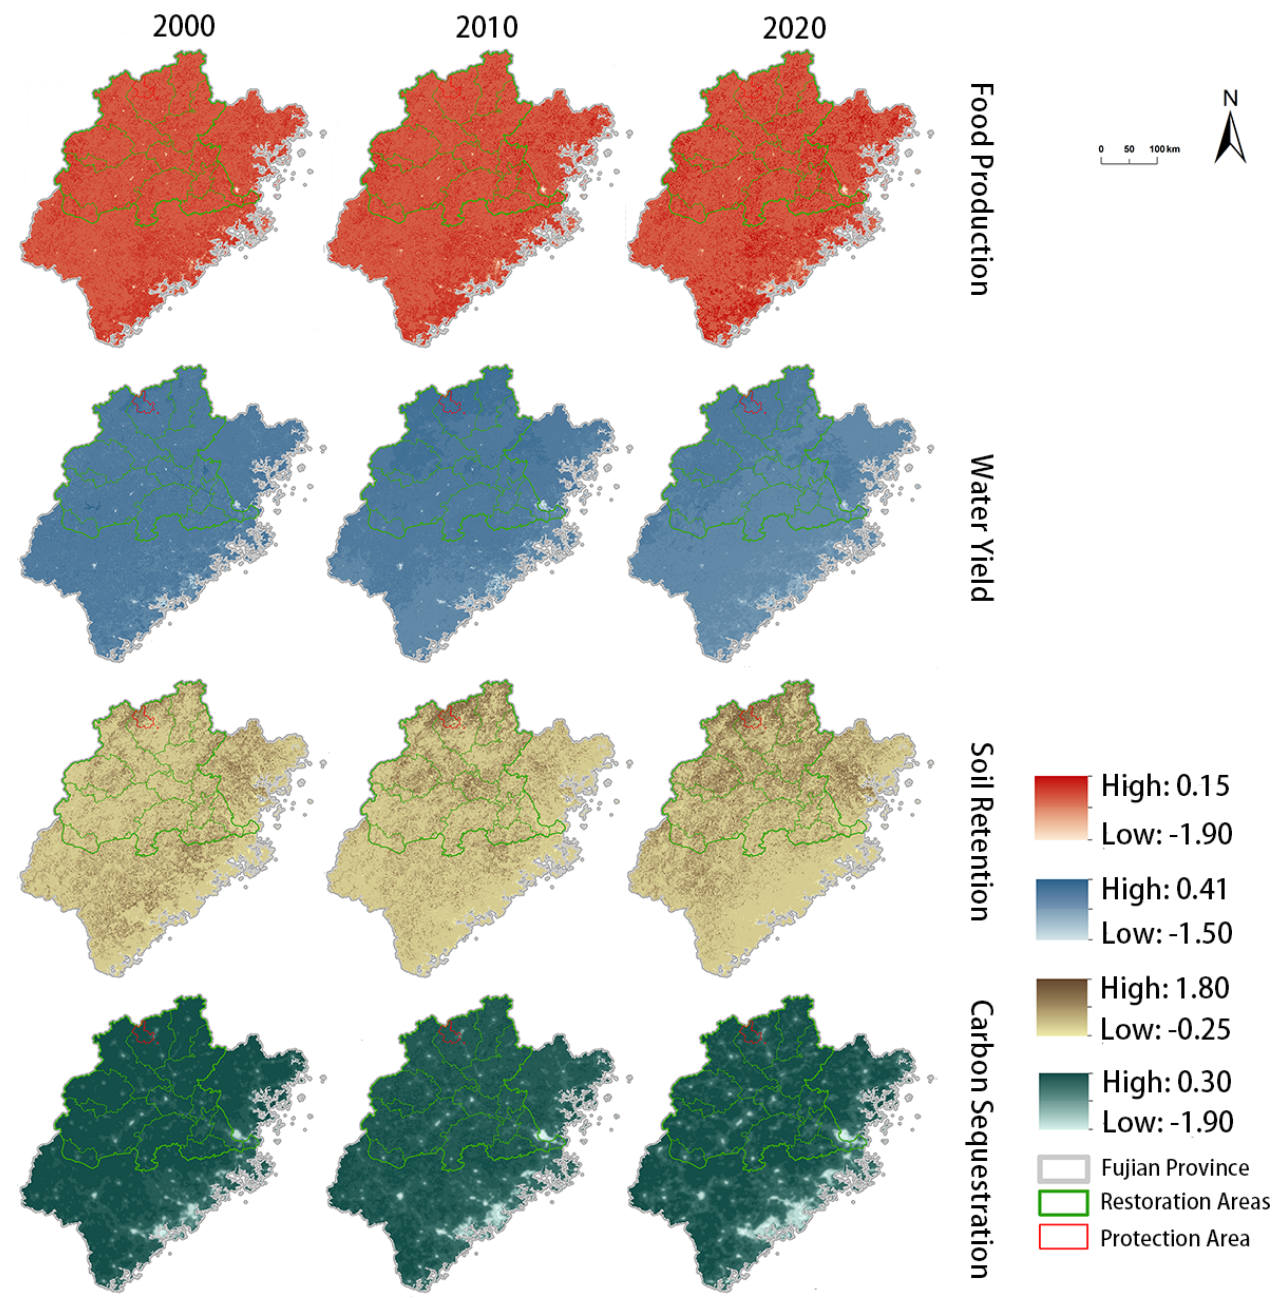
Figure 4. Variation in the ecosystem services supply-demand Figure 4 . Variation in the ecosystem services supply − demand ratio Table 6. The mean values of ecosystem services supply − demand ratios.